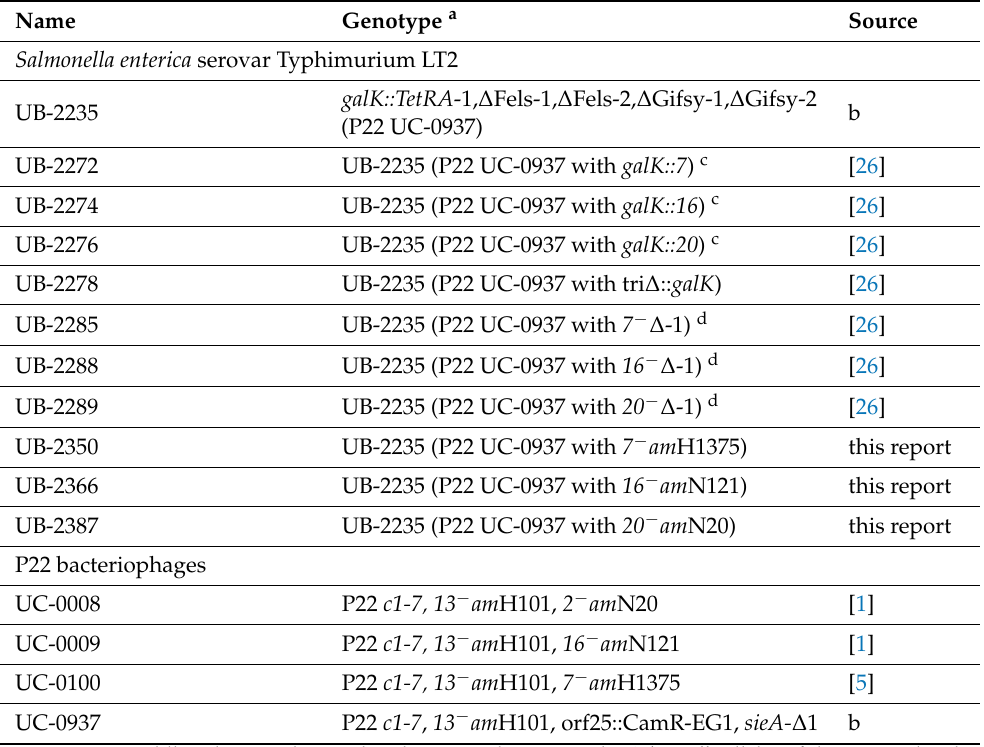
Table 1. Bacteria and bacteriophage strains used in this